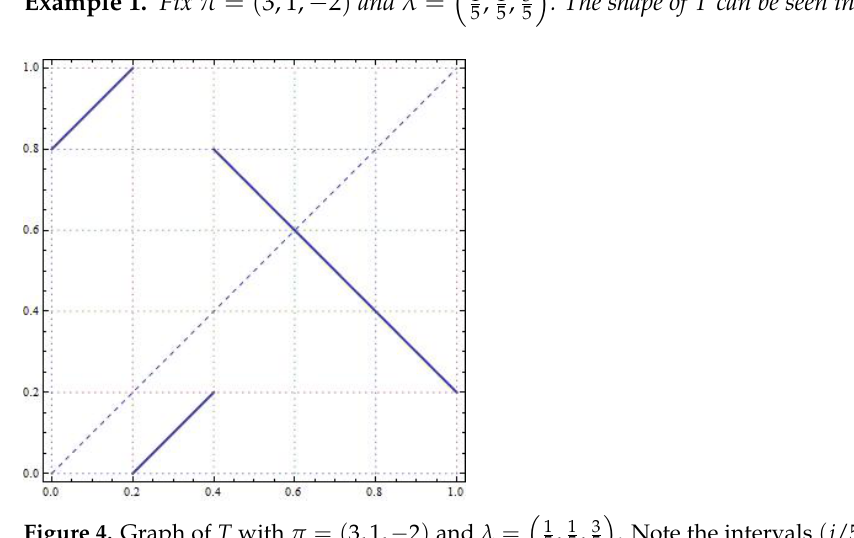
Figure 4. Graph of T with π = ( 3,1, − 2 ) and λ = j =